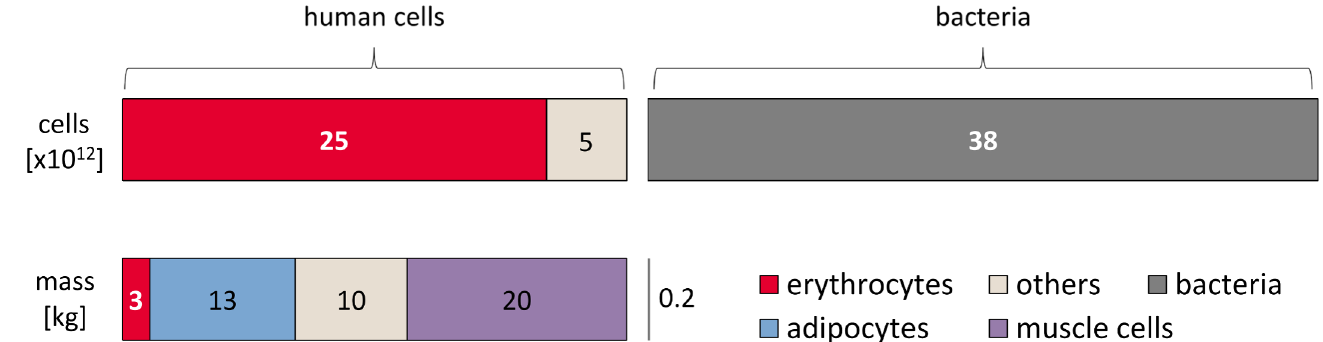
Fig 3. Distribution of cell number and mass for different cell types in the human body (for a 70 kg adult man). The upper bar displays the number of cells, while the lower bar displays the contribution from each of the main cell types comprising the overall cellular body mass (not including extracellular mass that adds another (cid:3) 24 kg). For comparison, the contribution of bacteria is shown on the right, amounting to only 0.2 kg, which is about 0.3% of the body